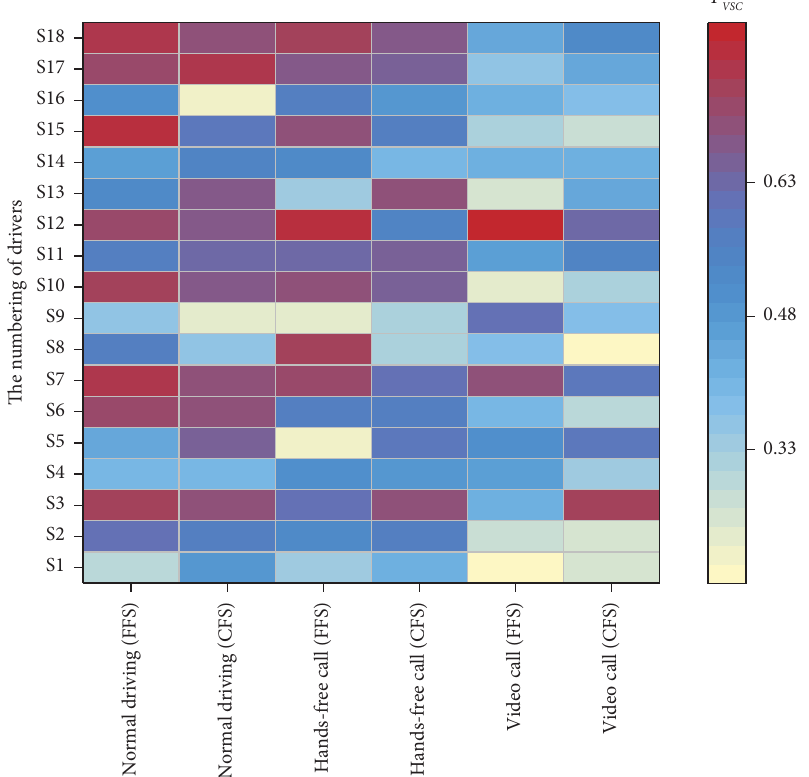
Figure 10: Heatmap of drivers’ VSC in diferent trafc conditions and driving